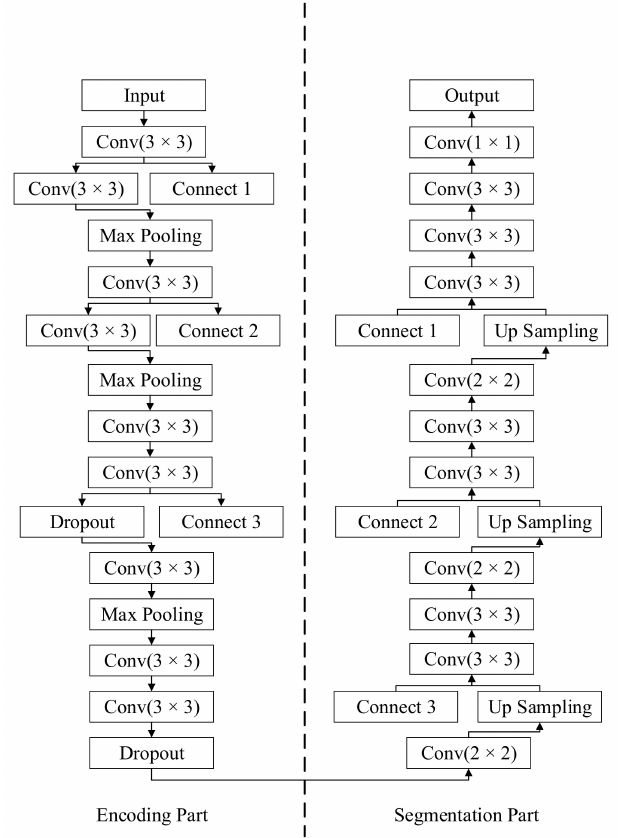
Figure 8. Structure of semi-supervised learning based model for plateau forest segmentation using the knowledge transformed from the unsupervised learning based model. The function of the layer blocks are explained as follows: ‘Input’ represents an input layer; ‘Conv 3 × 3’ represents a convolutional layer with an kernel size of 3 × 3; ‘Max Pooling’ represents a max pooling layer; ‘Dropout’ represents a dropout layer for avoiding over-fitting; ‘Up Sampling’ represents an up sampling layer; ‘Connect’ represents the connection layer, the connection layer with the same number as connecting with each other; ‘Conv 2 × 2’ represents a convolutional layer with an kernel size of 2 × 2; ‘Conv 1 × 1’ represents a convolutional layer with an kernel size of 1 × 1; ‘Output’ represents an output